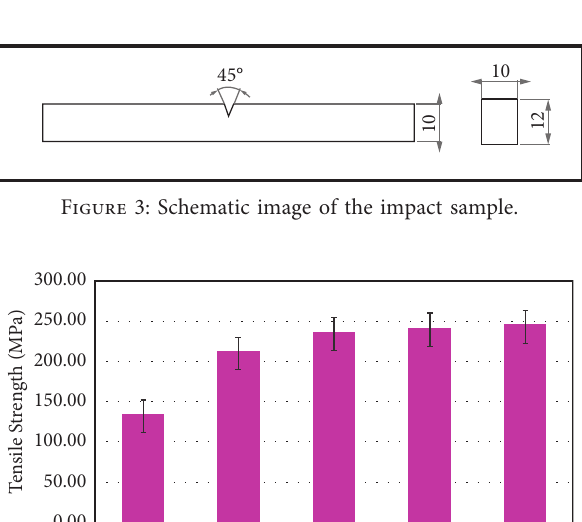
Figure 2: Impact tester.